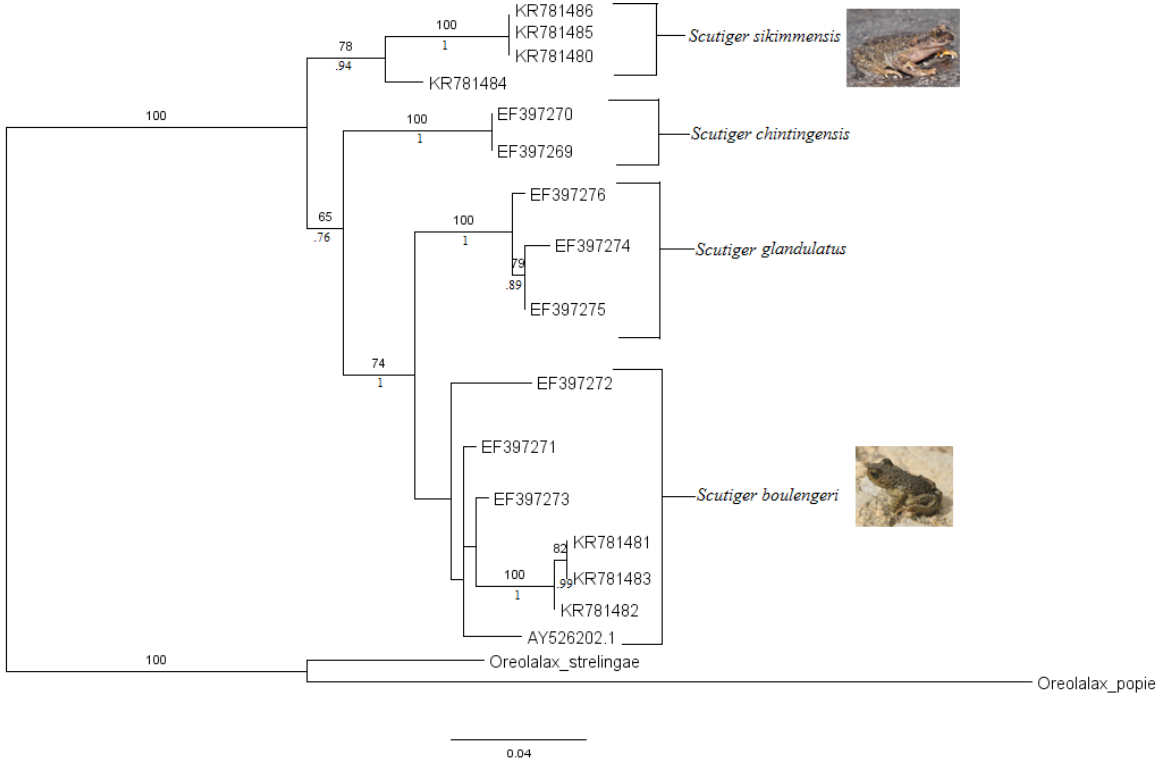
Figure 2. Molecular phylogenetic tree of S. boulengeri , S. glandulatus and S. sikimmensis using 16SrRNA dataset with Oreolalax spp. as outgroup. The values above the branches are Maximum Likelihood Bootstrap and below the branches are Bayesian Posterior Probability (BPP) generated using MrBayes. The nodes having value below 50% bootstrap and BPP 0.75 are not shown